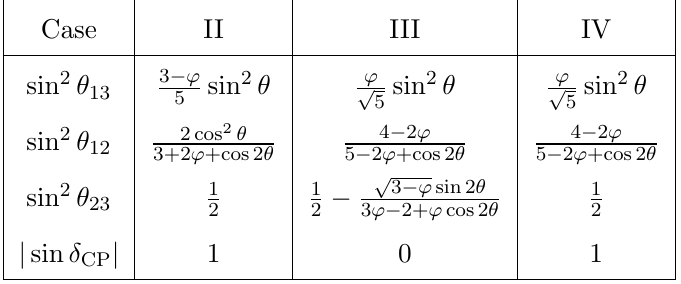
Table 4 . Predictions for the leptonic mixing parameters in terms of the free parameter (cid:18) in Cases II, III, and IV originating from G CP = A 5 o CP broken to G e = Z 5 and G (cid:23) = Z 2 ref. [31]. The quantity ’ = (1 + p 5) = 2 is the golden